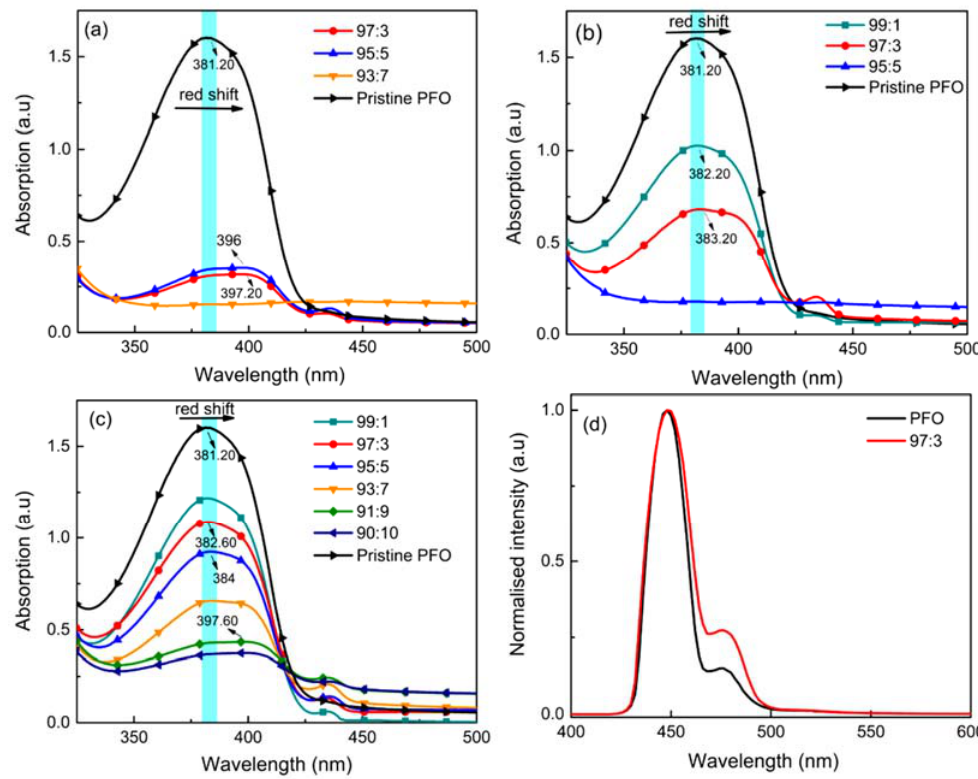
Figure 1. UV-Vis spectra of the PFO film and aggregated PFO films using various ratio of good to poor solvent of ( a ) ethanol, ( b ) isopropanol, and ( c ) methanol, and ( d ) normalised PL spectra for PFO and PFO with 97:3 induced aggregated films.